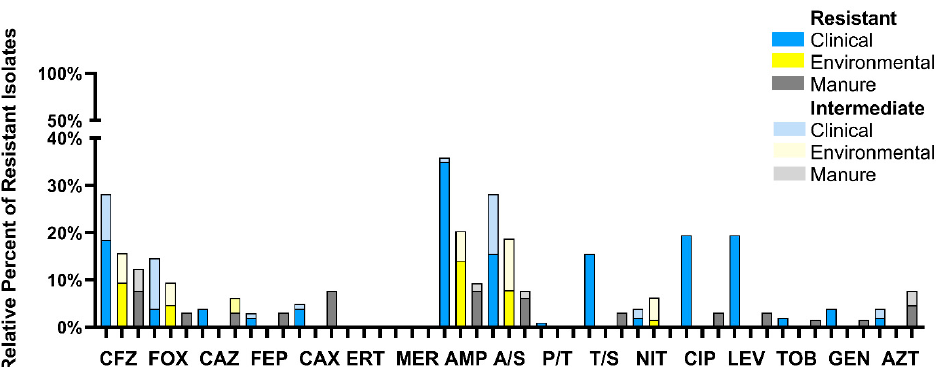
Figure 1. Percentage of resistant and intermediate resistant Escherichia coli isolates from clinical (blue), environmental (yellow), and manure (grey) environments. Antibiotic abbreviations: CFZ = cefazolin, FOX = cefoxitin, CAZ = ceftazidime, FEP = cefepime, CAX = ceftriaxone, ERT = ertapenem, MER = meropenem, AMP = ampicillin, A/S = ampicillin-sulbactam, P/T = piperacillin-tazobactam, T/S = trimethoprim-sulfamethoxazole, NIT = nitrofurantoin, CIP = ciprofloxacin, LEV = levofloxacin, TOB = tobramycin, GEN = gentamicin, AZT = aztreonam.